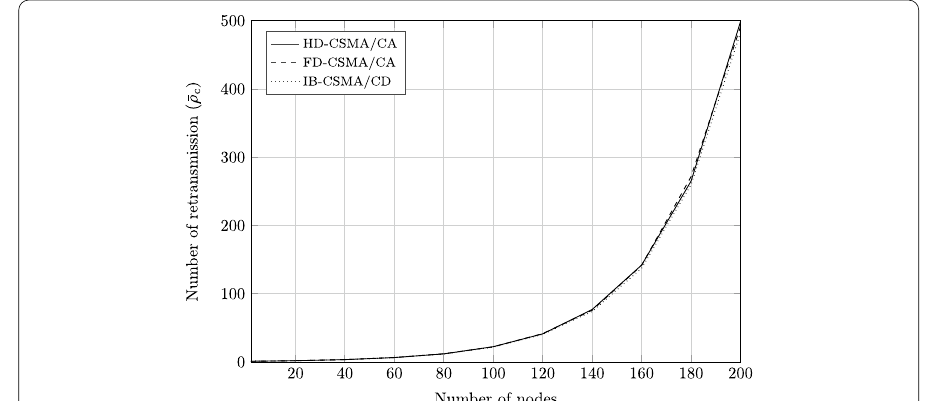
Fig. 7 Validation of the number of retransmission due to collisions in saturated and symmetric traffic